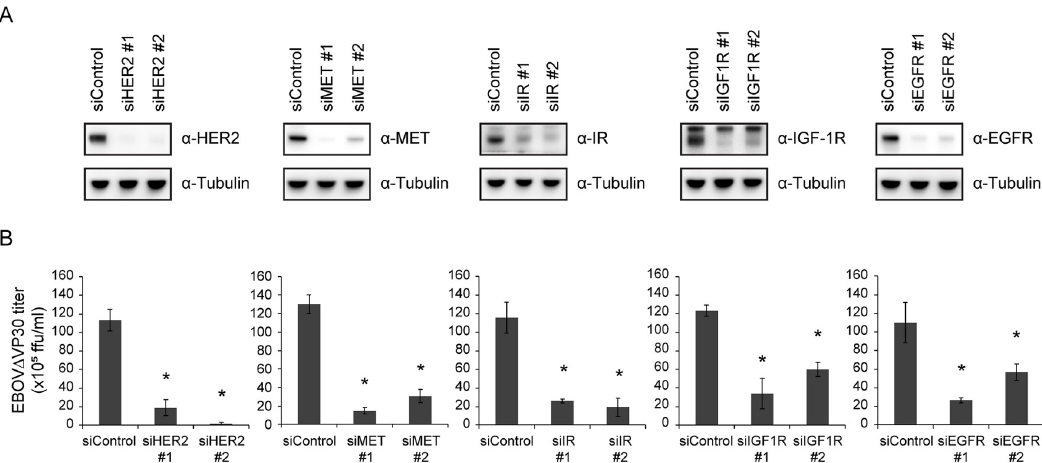
Fig 2. Reduction of EBOV Δ VP30 growth kinetics by siRNA knockdown of RTKs. (A) RTK expression in Huh7.0 VP30 cells after siRNA knockdown. Cells were transfected with siRNAs targeting each RTK or control siRNA. On day 3 post-transfection, cells were lysed and the indicated protein expression levels were analyzed by immunoblotting. (B) Cells were transfected with siRNA as described in (A). On day 3 post-transfection, cells were infected with EBOV Δ VP30 at an MOI of 0.01. Virus titers were determined on day 3 post-infection. Data are presented as means ± SD, and are representative of experiments performed in triplicate and repeated twice. ( � ) indicates a statistically significant difference ( p value � 0.05) from the control.